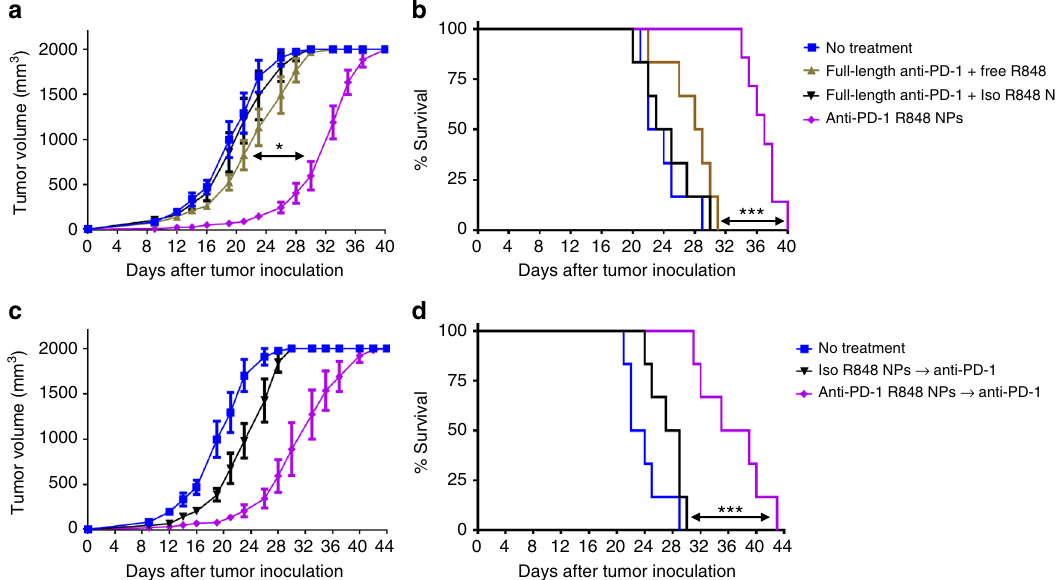
Fig. 7 Targeted delivery of a TLR7/8 agonist (R848) to PD-1-expressing cells extends survival and sensitizes tumors to anti-PD-1. C57BL/6 mice were inoculated subcutaneously with 200,000 MC38 cells. a , b Starting on day 5, nanoparticles or free drugs were administered intravenously every other day up to a total of 10 injections. The dose was 20 μ g of anti-PD-1 and 60 μ g of R848 per injection. Tumor volume and animal survival were monitored to assess anti-tumor ef fi cacy. c , d Nanoparticles or free drugs (20 μ g of anti-PD-1 and 60 μ g of R848) were administered intravenously on days 5, 7, and 9 post-tumor inoculation to activate the innate immune system and thereby in fl ame the tumor. On days 11, 14, and 17, anti-PD-1 antibody (clone 29 F.1A12, 200 μ g) was injected intraperitoneally, as this IgG is typically administered. Tumor volume and animal survival were monitored to assess for ef fi cacy ( n = 6 – 7, mean ± s.e.m; * p < 0.05; *** p < 0.001, Mantel-Cox